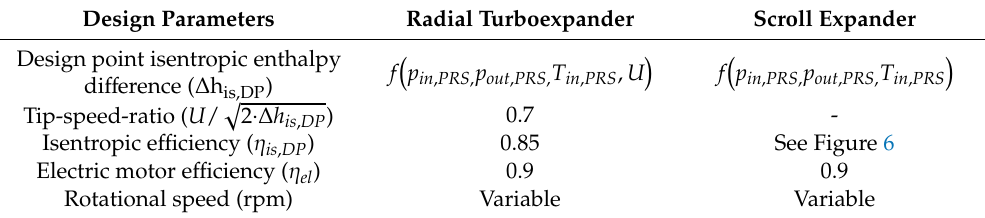
Figure 5. Dimensionless step (linked dots) and original (dashed line) function of the natural gas mass flow rate flowing through a reference PRS. Table 1. Design parameters of radial and scroll